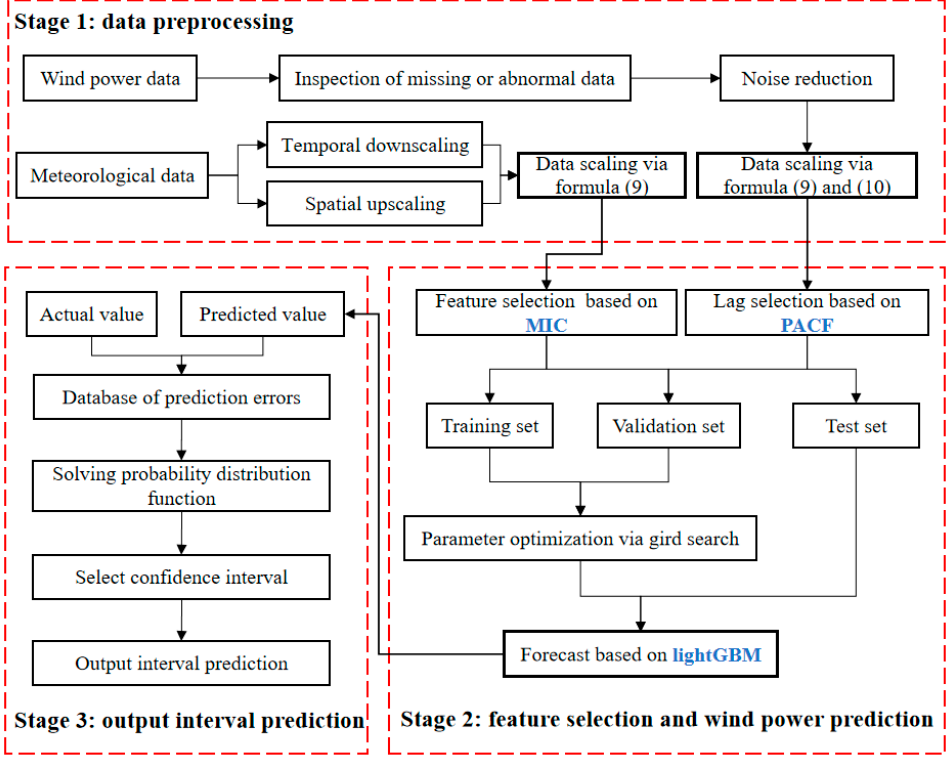
Figure 2. Overview of the framework.